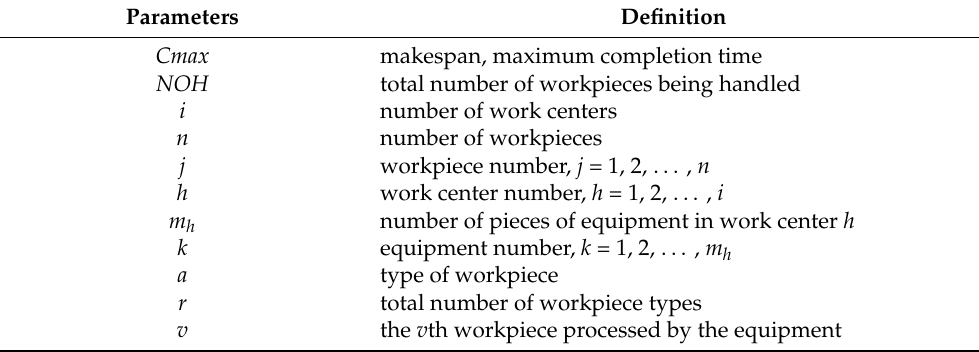
Table 1. Definition of parameters.